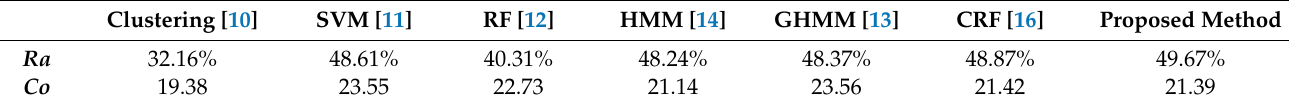
Table 4. Result of scene image gazing with small target saliency.